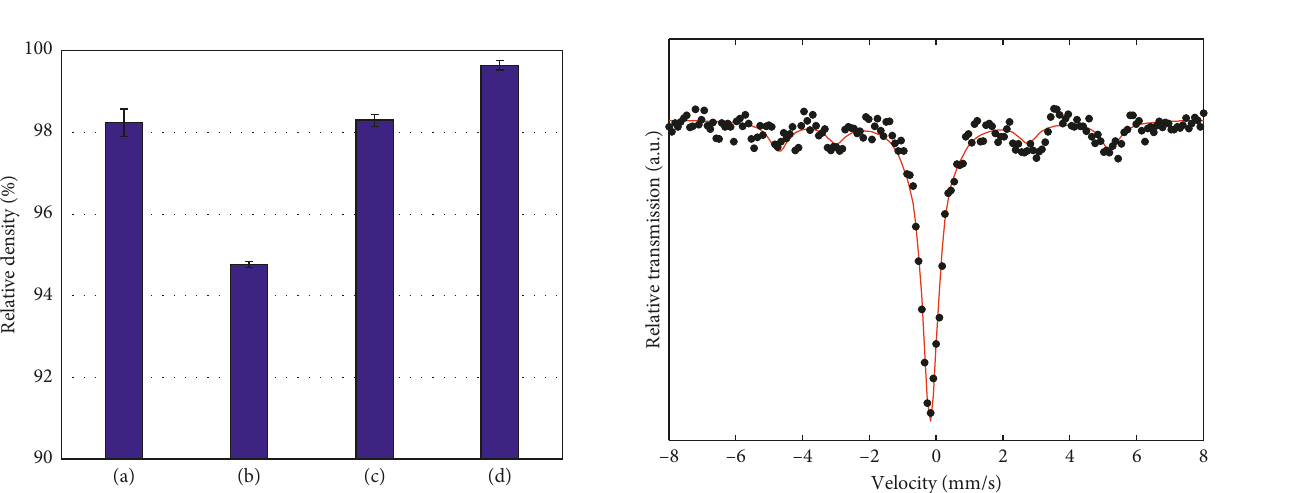
Figure 7: M¨ossbauer spectra for Fe-30Mn-5.9Si-0.1C powders after MA for